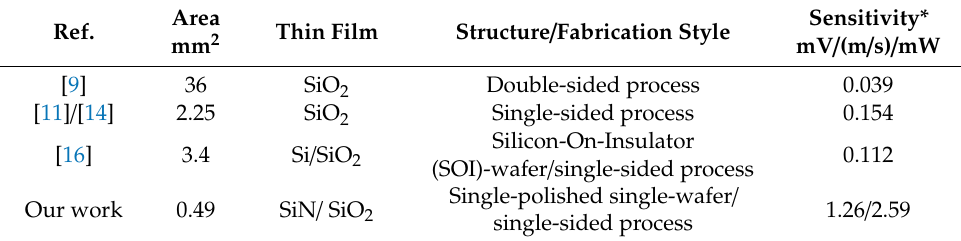
Table 2. Summary of the previous thermoresistive calorimetric flow sensors and our work. Ref. Ref.